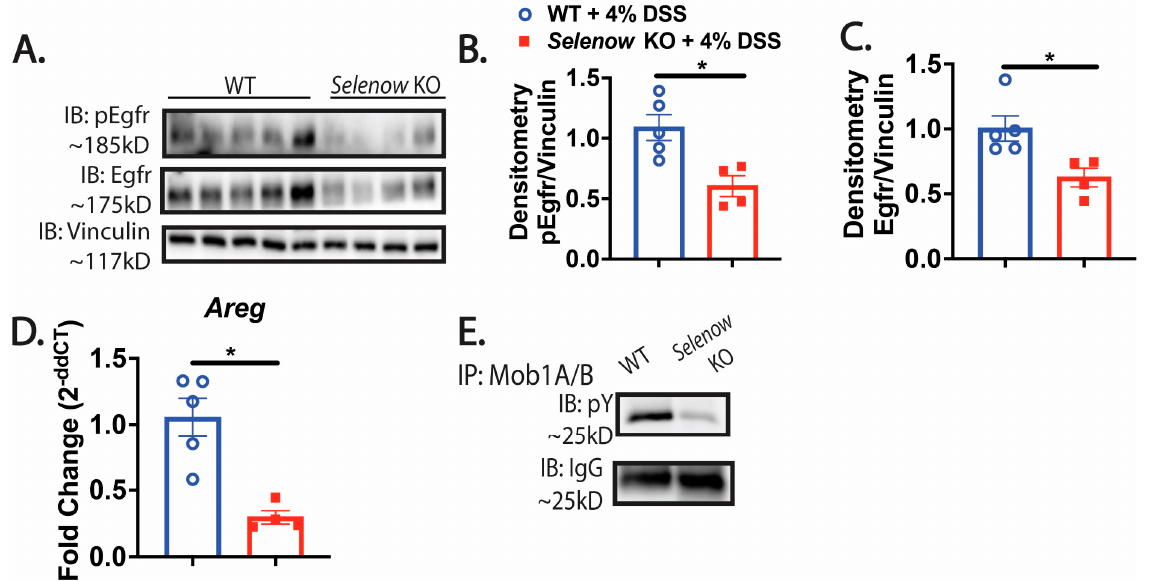
Figure 7. Selenow KO mice have decreased Egfr expression following injury. ( A ) Representative immunoblot of pEgfr (Y1068) and Egfr. ( B , C ) Quantification of pEgfr (Y1068) and Egfr from colonic lysates of WT and Selenow KO mice at day 8 post DSS (WT = 5 mice; Selenow KO = 4). ( D ) Areg mRNA expression in colon of WT and Selenow KO mice at day 8 post DSS (WT = 5 mice; Selenow KO = 4). ( E ) Immunoprecipitation of Mob1A/B with representative immunoblot of phospho-tyrosine (pY) from colonic lysates of WT and Selenow KO mice at day 8 post DSS. Data indicate mean ± SEM.